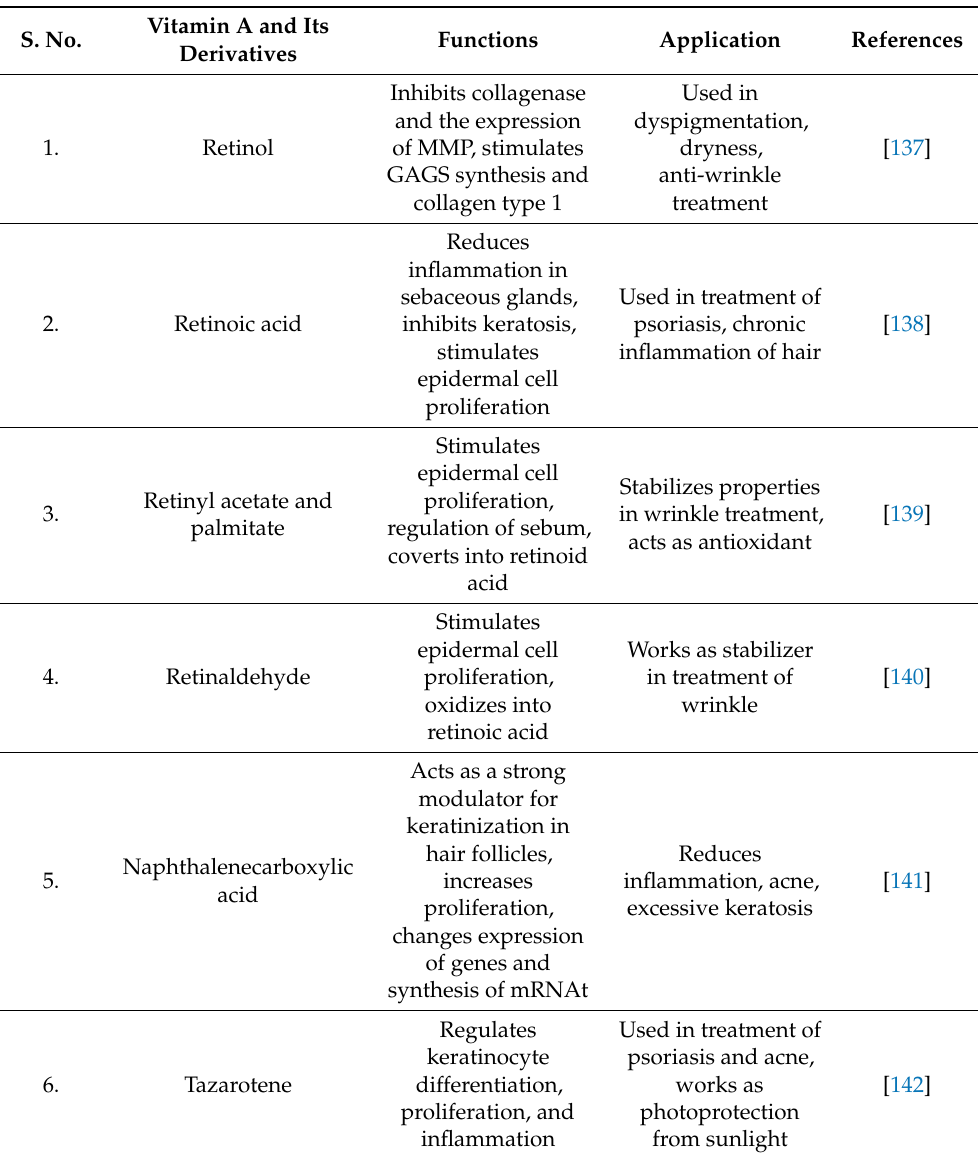
Table 2. Vitamin A uses in cosmetics and